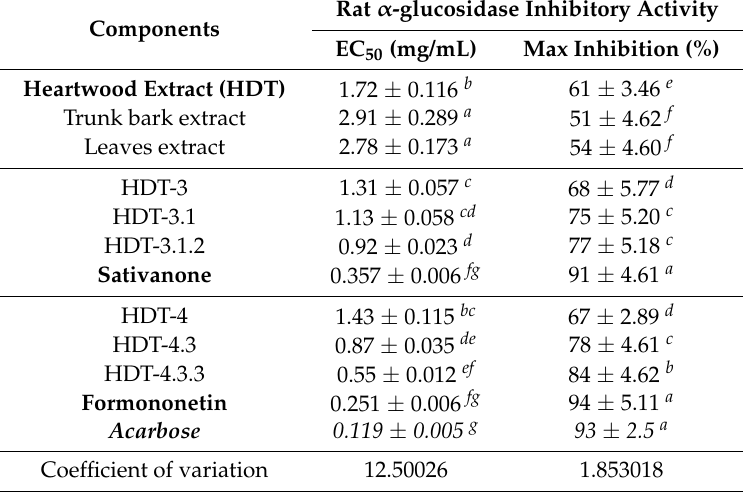
Table 4. Rat α -glucosidase inhibitory activity of crude extracts, fractions, sub-fractions, and isolated compounds from Dalbergia tonkinensis